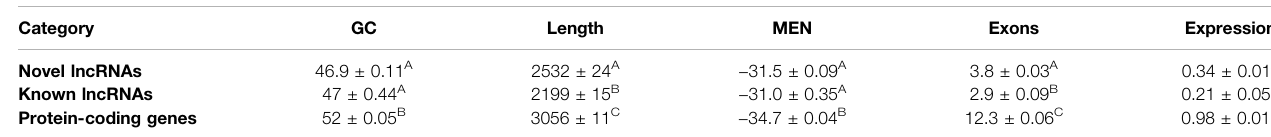
TABLE 1 | Comparison of novel lncRNAs, known lncRNAs, and protein-coding genes.